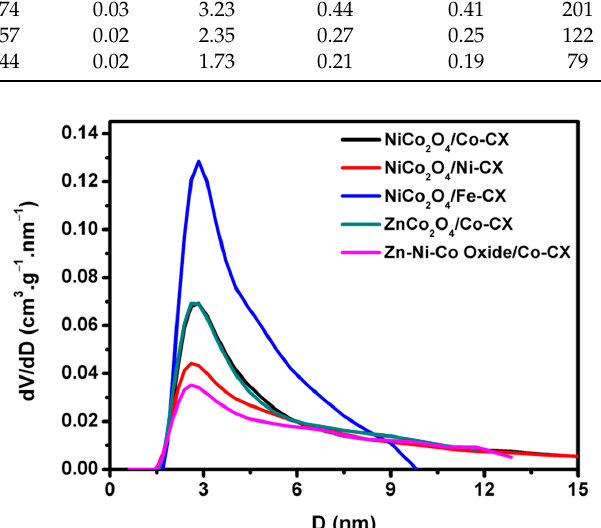
Figure 1. Pore size distribution from QSDFT analysis for the adsorption part of N 2 isotherms.